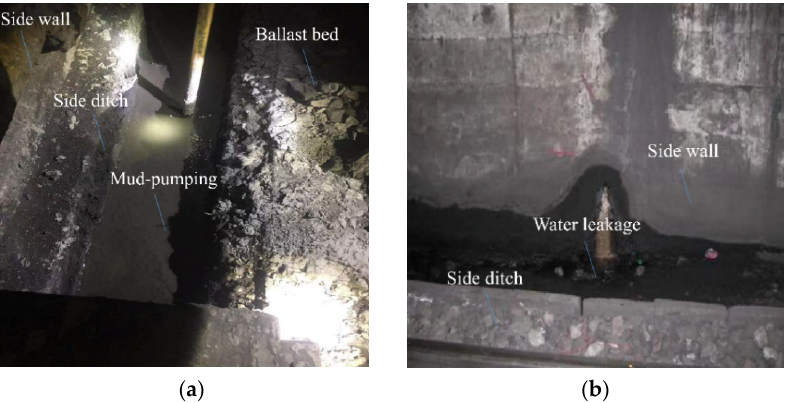
Figure 1. Main damage to heavy-duty railway tunnels: ( a ) Mud-pumping; ( b ) Leakage of lining.